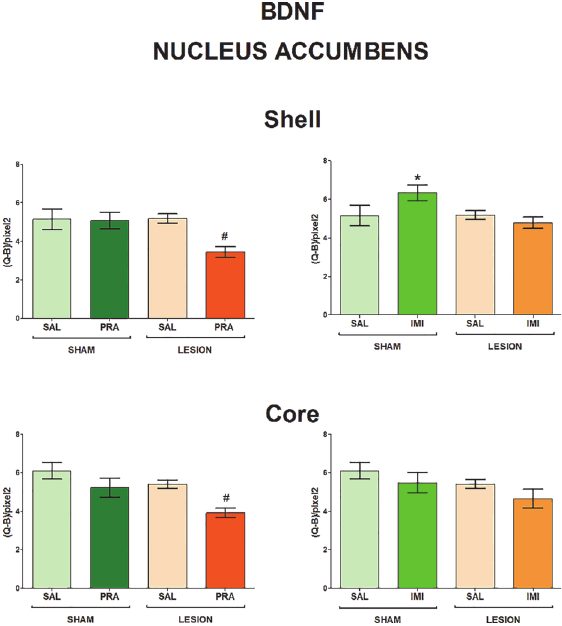
Fig 6. The influence of 6-OHDA, pramipexole and imipramine on BDNF mRNA in the nucleus accumbens. n = 9 – 10. For further explanations see Figs. 1 and 2.